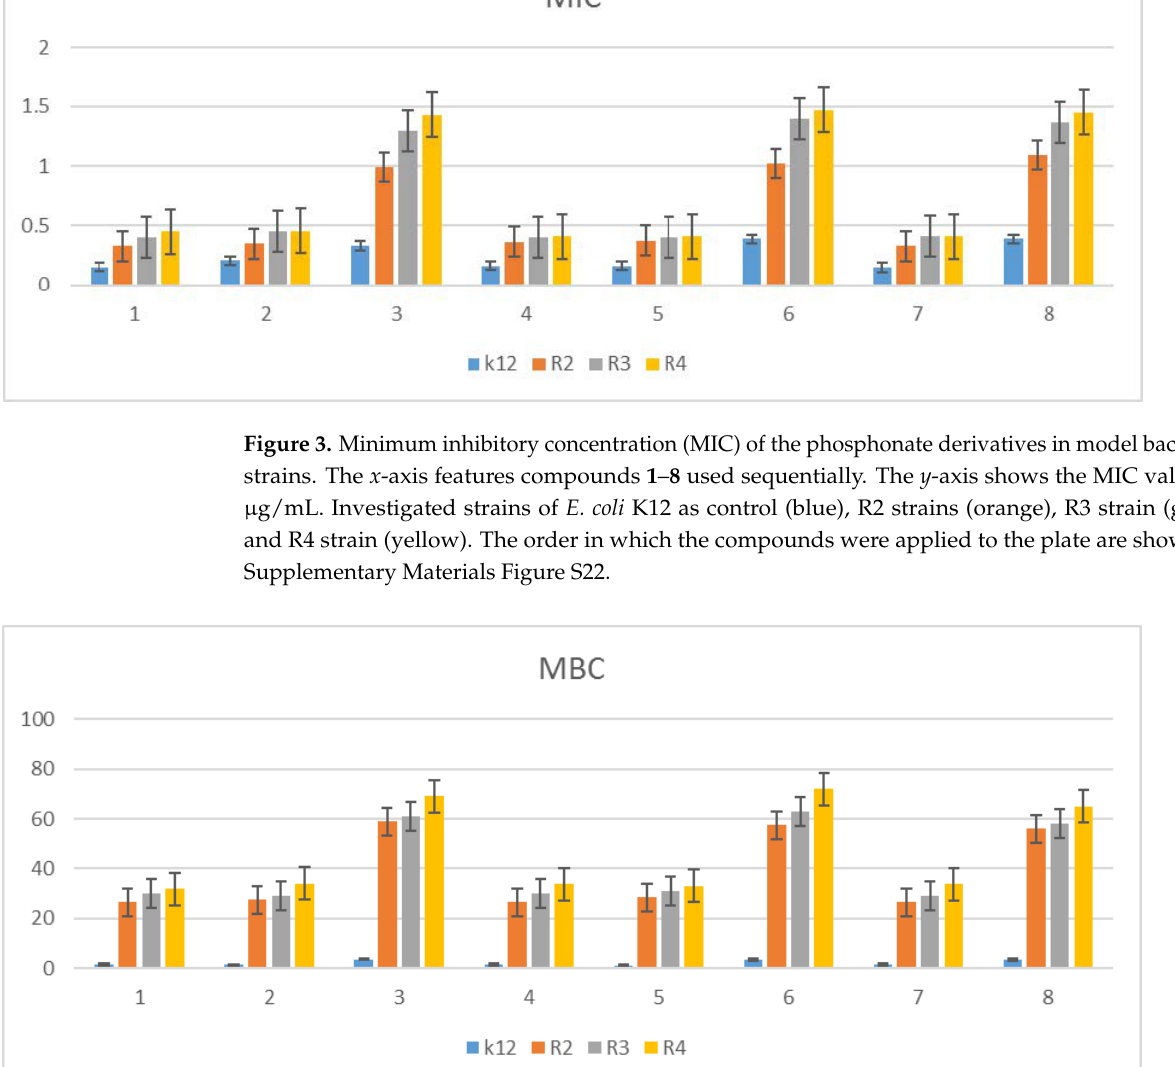
Figure 4. Minimum bactericidal concentration (MBC) of the phosphonate derivatives. The x -axis features compounds 1 – 8 used sequentially. The y -axis shows the MBC value in µg/mL. Investigated strains of E. coli K12 as control (blue), R2 strains (orange), R3 strain (grey), and R4 strain (yellow). The order in which the compounds were applied to the plate are shown in Supplementary Materials Figure S22.